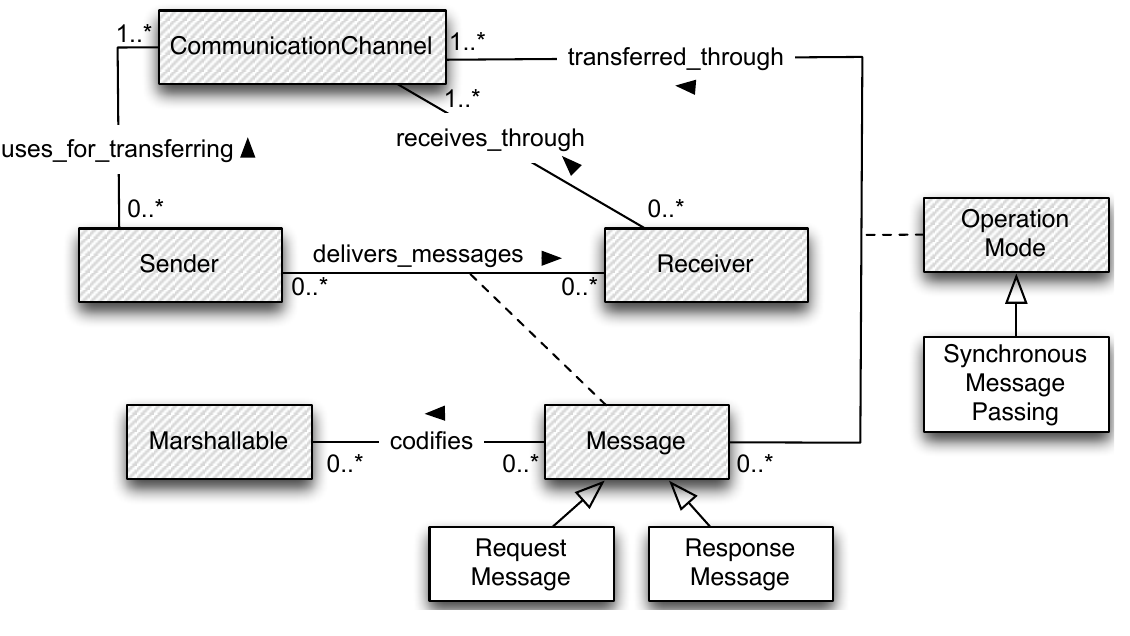
Figure 2. Specialized model to support RR semantics.